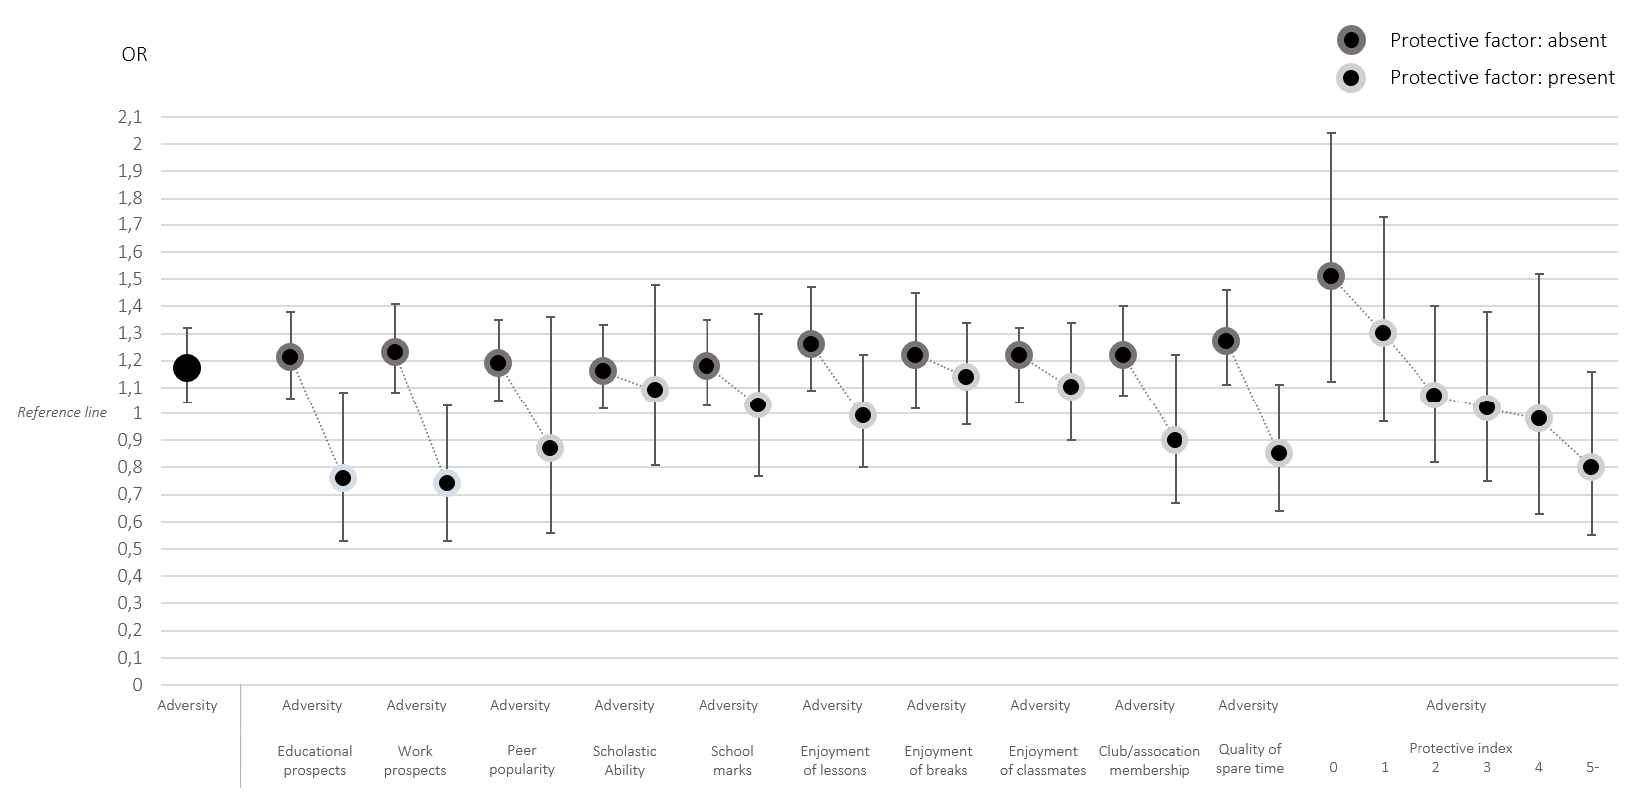
Figure 1. Associations between social and material adversity (ranging between 0 and 6) at T1 (age 16) and self ‐ rated health at T2 (age 43), stratified by (the absence or presence of) each separate protective factor at T1. Results from ordinal regression analysis, presented as odds ratios with 95% confidence intervals ( n = 908). Adjusted for gender, internalising symptoms, and functional somatic symptoms at baseline. The outcome, self ‐ rated health (ranging between 1 and 3), is coded so that higher vales indicate poorer health.